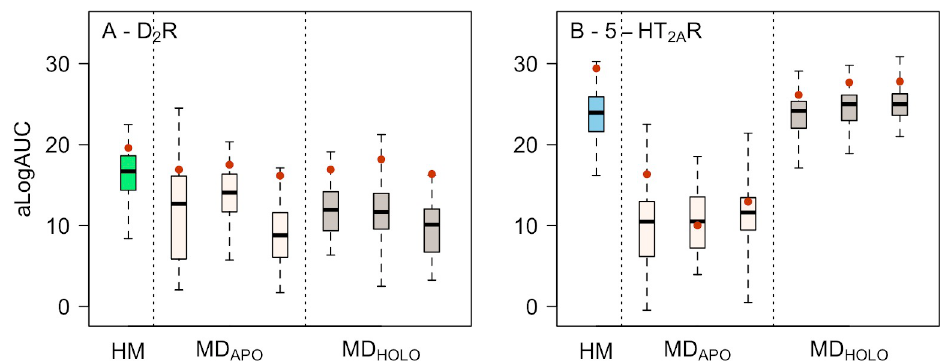
Fig 8. Ligand enrichment by MD simulation snapshots. Distributions of aLogAUC values for 50 homology models (HM) and sets of 50 snapshots from three MD simulations per template for the (A) D 2 R based on the D 3 R template and (B) 5-HT 2A R based on the 5-HT 2C R template. Results for HM, apo (MD APO ), and holo forms (MD HOLO ) are shown using a boxplot representation. The box represents the 50th percentile of the data and the black band shows the median value. The lowest and highest alogAUC values are represented by the whiskers. The ensemble enrichments of each set of 50 models are represented by red filled circles.